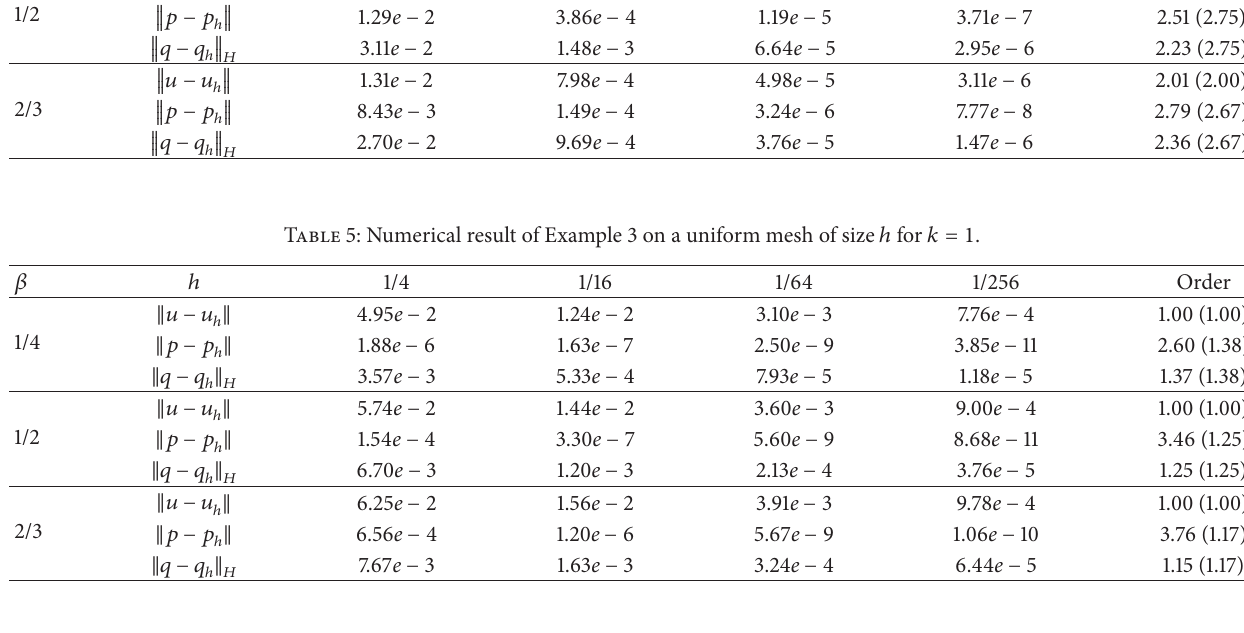
Table 6: Numerical result of Example 3 on a uniform mesh of size ℎ for 𝑘 = 2